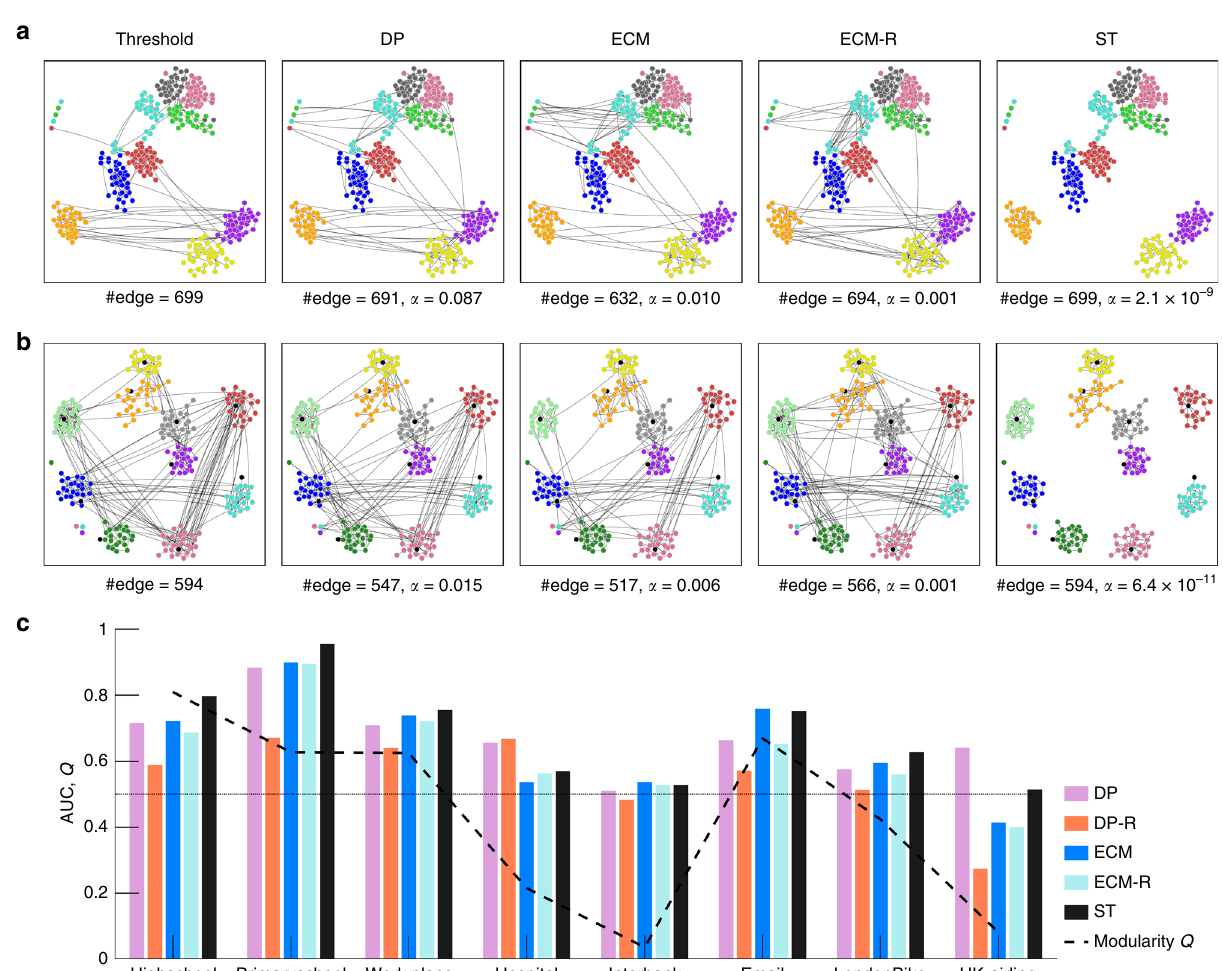
Fig. 5 Backbones and community structure. Visualization of the backbones obtained by different fi ltering methods, at similar numbers of edges, for the a Highschool and b Primaryschool data sets. The nodes are shown in the same position for all the backbones of a given data set. “ Threshold ” corresponds to a simple thresholding procedure on the aggregated network. Different colors denote different classes. For the Primaryschool data, black circles represent the teachers. The ST fi lter detects a larger fraction of intra-class edges than the other fi ltering methods. c AUC of the ROC curve (see Supplementary Figure 9 for the ROC curves) for the identi fi cation of intra-community edges. The black dashed curve gives the weighted modularity Q 42,43 calculated by regarding the actual groups (classes for Primaryschool and Highschool, departments for Workplace, and roles for Hospital) as communities in the original aggregate networks. For the Interbank data set, banks are classi fi ed into Italian banks and foreign banks. For Email, LondonBike, and UK-airline, the communities are detected by Infomap